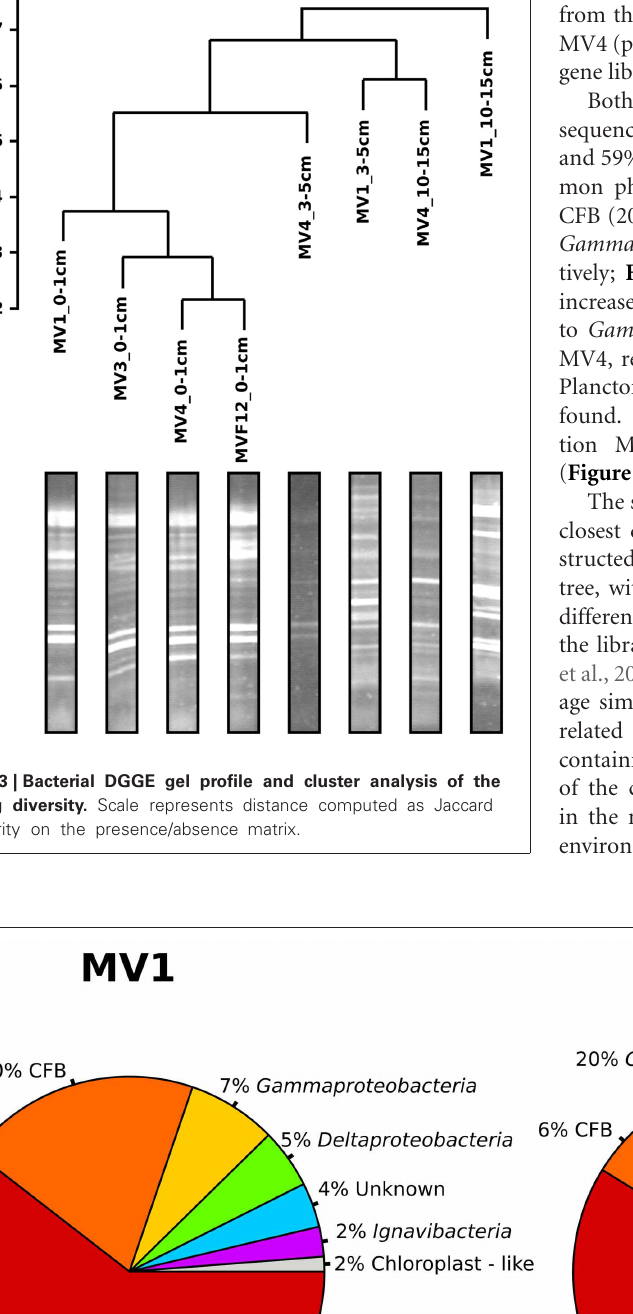
Frontiers in Microbiology | Extreme